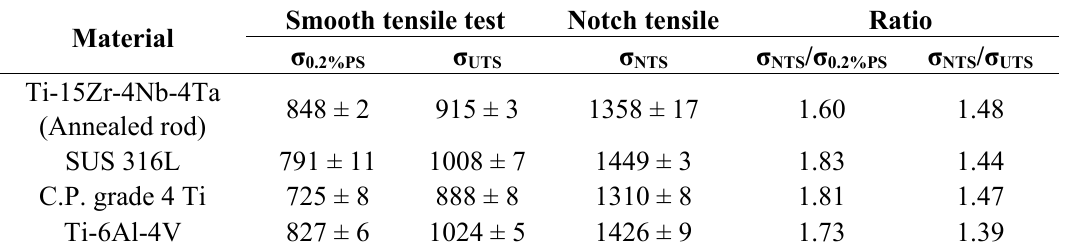
Table 3. Comparison of smooth and notched tensile ( K work and reported in the literature among different materials